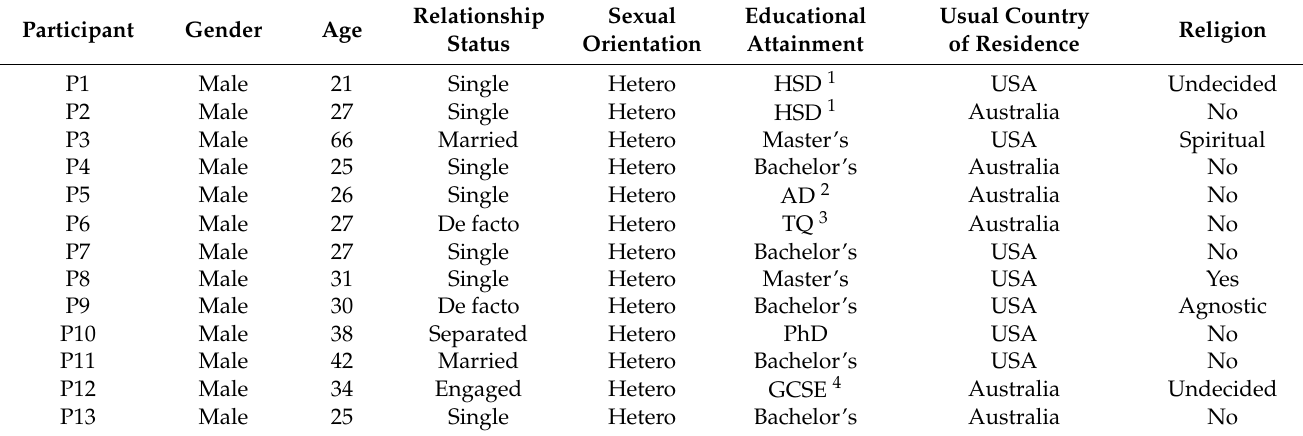
Table 2. Participant table—summary of participants’ demographic information ( n =